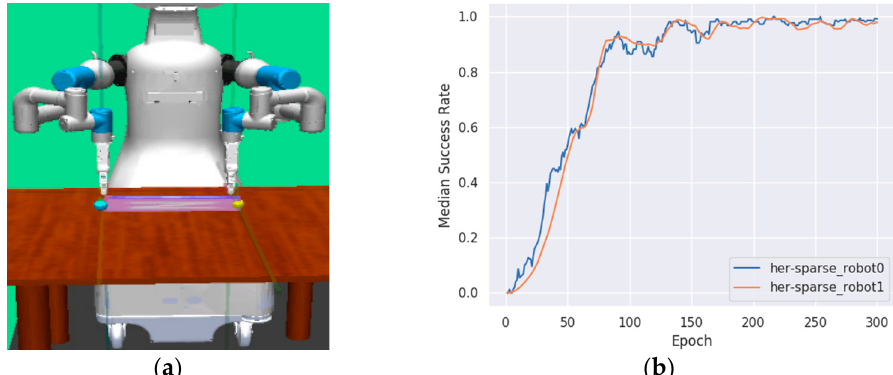
Figure 2. Reach scene. ( a ) The left and right target positions are randomly chosen in 3D space. Control the left and right end effectors of the robot to reach the left and right targets as quickly as Figure 3. Push scene. ( a ) The task is to move a block placed on the table in front of the robot to the possible. ( b ) The learning curve of Reach scene—the abscissa is the number of training rounds and target position on the table. ( b ) The learning curve of Push scene—the abscissa is the number of the ordinate is the average success rate of 10 tests. training rounds and the ordinate is the average success rate of 10 tests.